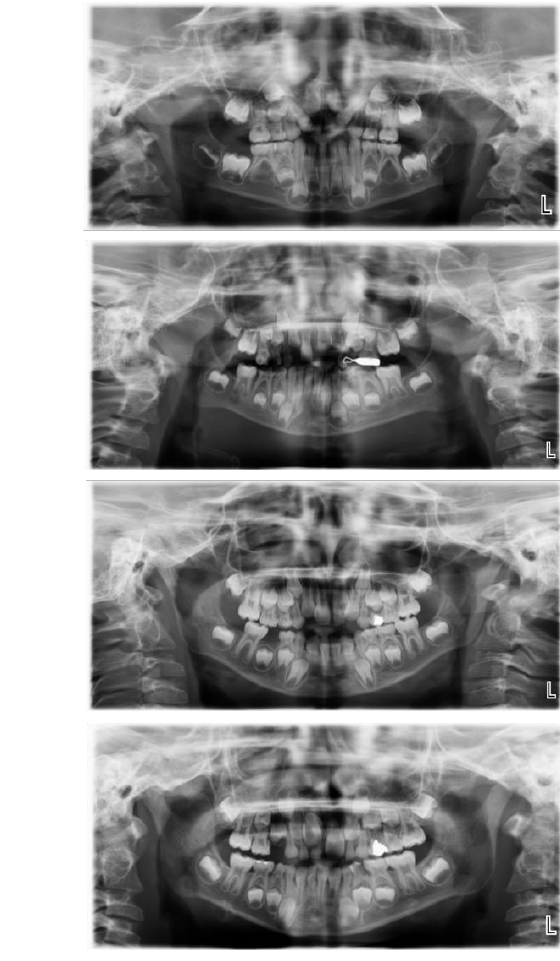
Figure 1. ( a ) Panoramic radiograph showing delayed eruption of permanent upper central incisor due to cleft lip and palate and insufficient space. ( b ) Delayed eruption of permanent upper central incisors due to early loss of primary upper central incisors. ( c ) Delayed eruption of permanent upper central incisors due to retained primary upper left central incisors. ( d ) Delayed eruption of perma- nent upper central incisors due to retained primary upper incisors and the presence of supernumer- ary teeth.